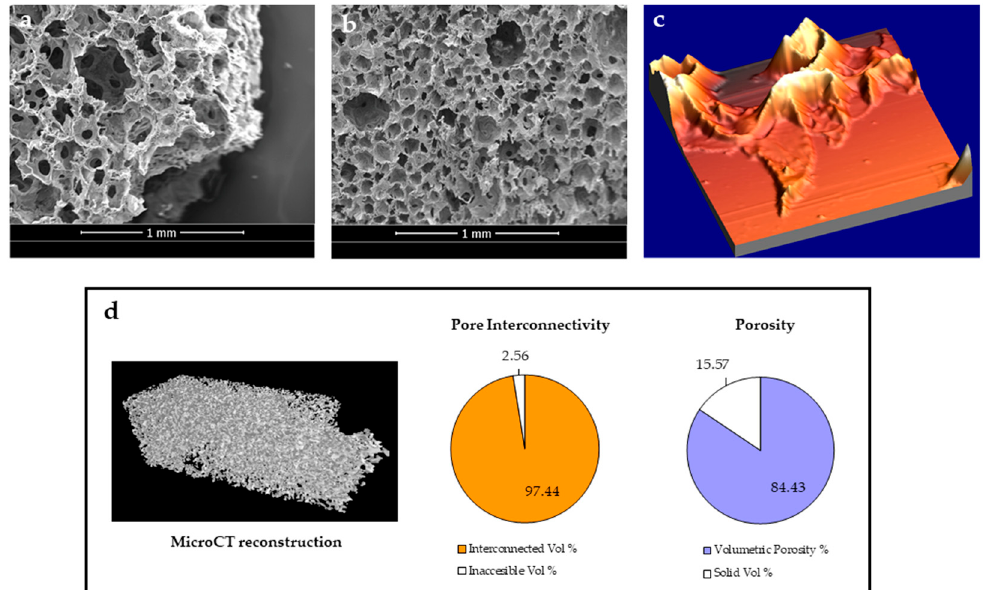
Figure 1. Results of morphological analysis of PVA/G sponges, showing: ( a , b ) SEM micrographs of 80/20 and 70/30 ( w /w%) compositions, respectively, taken at 100 × magnification and 15 kV; ( c ) AFM image displaying the PVA/G 80/20 ( w /w%) sponge inner topography in 40 × 40 µ m 2 (1024 × 1024 pixel) area; ( d ) the results of microCT analysis, including a 3D reconstruction of the PVA/G 80/20 ( w /w%) sponge, the calculated percentages of volumetric pore interconnectivity and